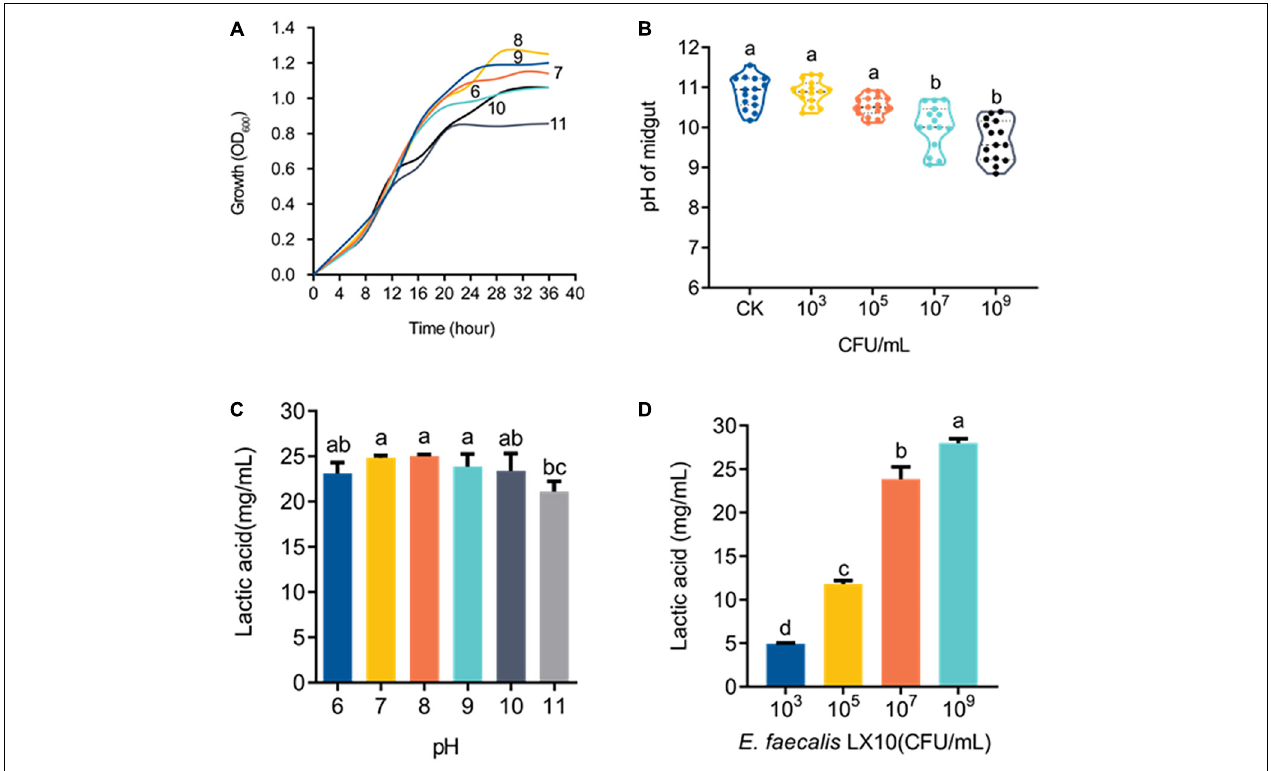
FIGURE 5 | E. faecalis LX10 significantly reduces the intestinal pH and efficiently produces lactic acid. (A) Growth curves of the E. faecalis LX10 strain inoculated under pH-buffered conditions (pH: 6–11). (B) The pH of the germ-free silkworm gut after treatment with E. faecalis LX10 (CK, 10 3 , 10 6 , and 10 9 CFU/mL). pH values are shown as the mean ± SE ( n = 10). (C) Comparison of lactic acid production by E. faecalis LX10 (10 7 CFU/mL) at different initial pH levels ( n = 5, p > 0.05). (D) Lactic acid production by E. faecalis LX10 at different concentrations (10 3 , 10 5 , 10 7 , and 10 9 CFU/mL; n = 5, p > 0.05). Different letters represent significant differences between groups according to Tukey’s honestly significant difference test (HSD, p < 0.05); ns not